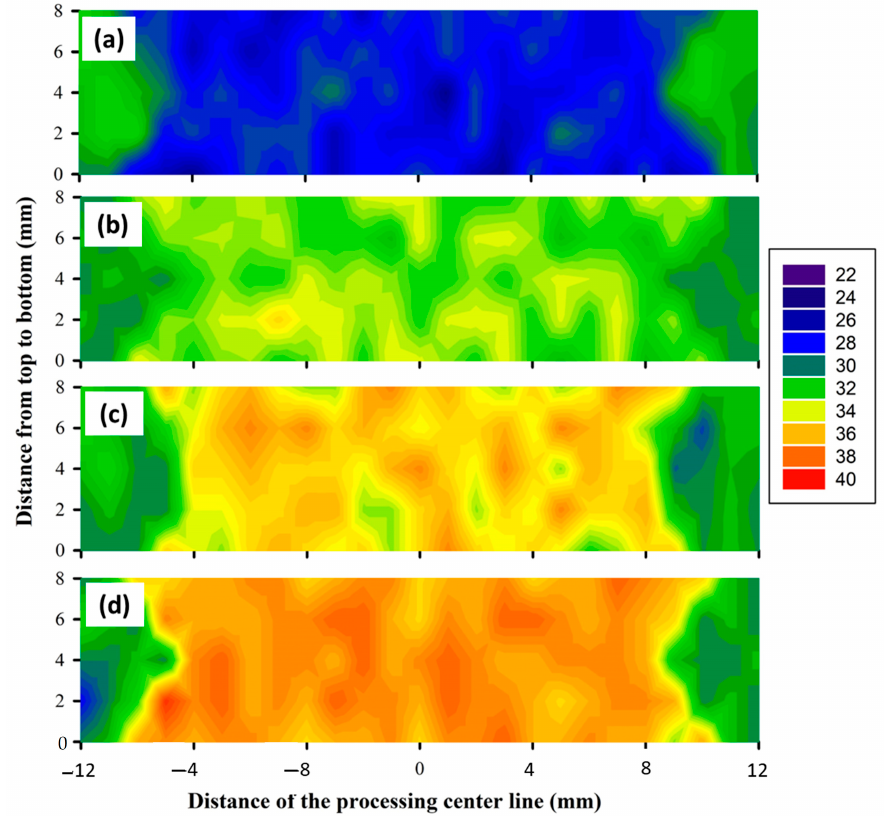
Figure 18. Hardness contour maps for the AA1050 BT-FSPed using Cy pin geometry at ( a ) 50, ( b ) 100, ( c ) 200, and ( d ) 300 mm/min, respectively.